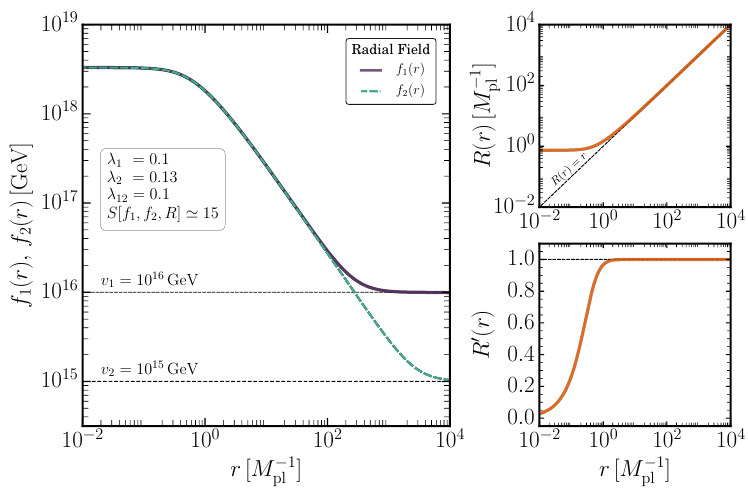
Figure 2 . An explicit solution to eqs. (4.3)–(4.6) for the case of two scalar fields charged under a global U(1) × U(1) symmetry. Shown are the results for v 1 = 10 16 GeV , v 2 = 10 15 GeV , (cid:15) 1 = 0 . 1 , (cid:15) 2 = 0 . 13 ? and (cid:15) 12 = 0 . 1 . The value of the action for this configuration is also shown. Left Panel: the radial field profiles f 1 , 2 ( r ) . Right Panels: the behaviour of the metric function R ( r ) and its derivative as a function of the radial co-ordinate. We note the expected behaviour of an asymptotically flat space-time at large r . ? To motivate this choice, note that the Higgs quartic coupling λ H = m 2 / 2 v 2 ’ 0 . 13 where m H ∼ 125 GeV is the mass of the Higgs boson and v ∼ H 246 GeV is its vacuum expectation